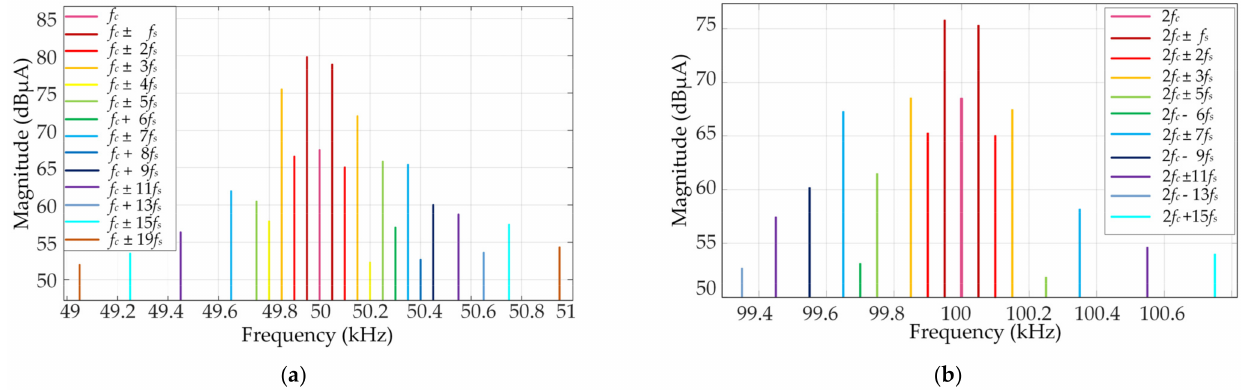
Figure 14. Detailed spectrograms, where f c is the carrier wave frequency (switching frequency), f s is the fundamental frequency. ( a ) Spectrum around 50 kHz. ( b ) Spectrum around 100